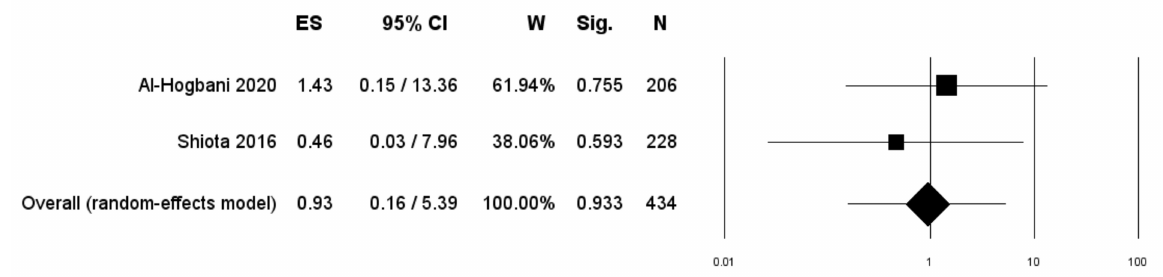
Figure 6. Forest plot showing the association between use of 5-ARIs and the RR of BCa progression. ES: Effect Size; CI: Confidence Interval. (I 2 = 0.00, p =